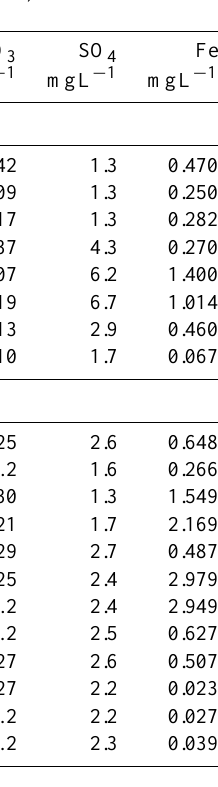
Table 1. Limnological properties of ponds and lakes sampled in July 2013 and July 2014, including sampling depth, dissolved organic carbon (DOC), absorption coefficient of dissolved organic matter at 320nm ( a 320 ) , total phosphorus (TP), soluble reactive phosphorus (SRP), total nitrogen (TN), and selected major ions (NO 3 , SO 4 , Fe). POL = polygonal pond; IWT = ice wedge trough pond; LAK =